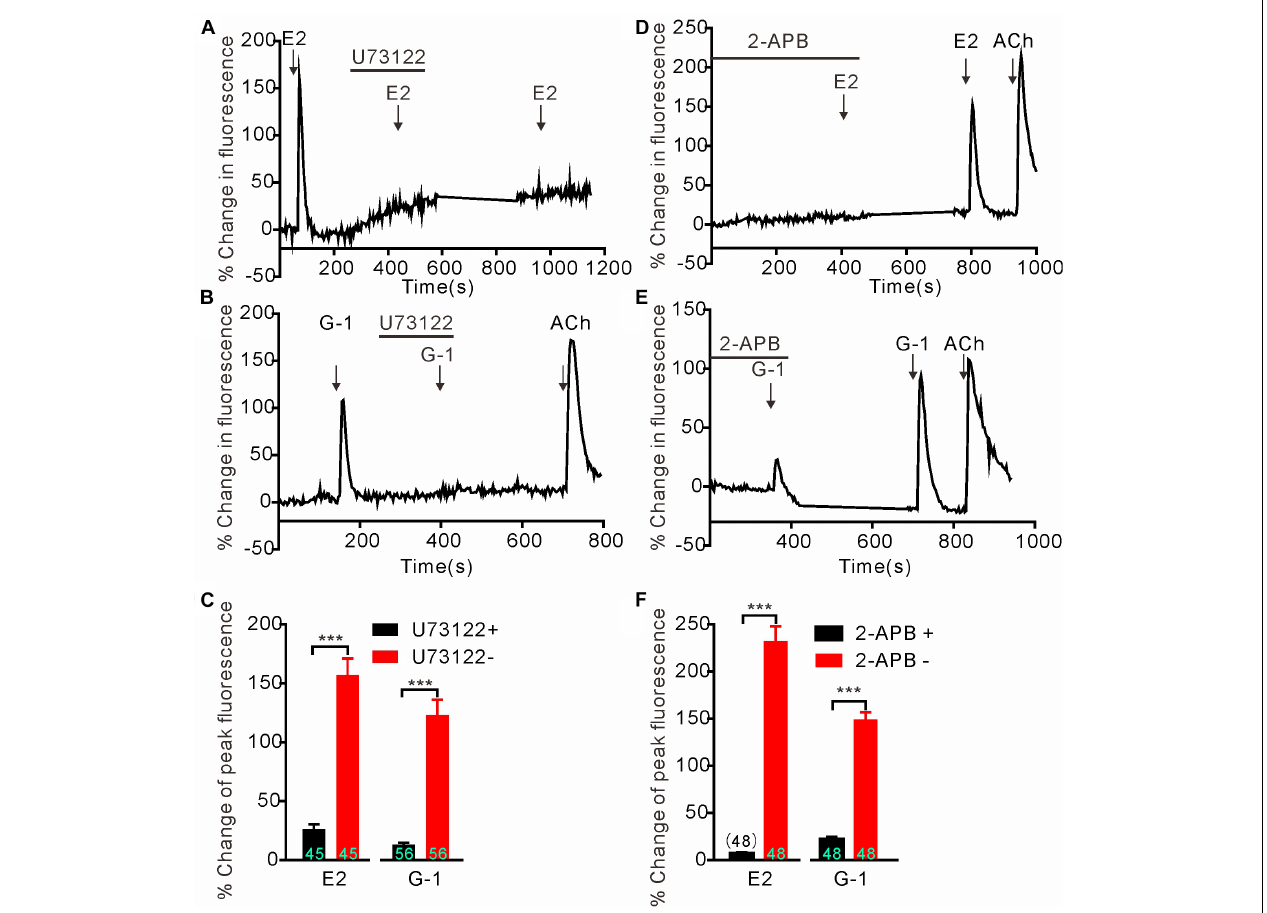
FIGURE 3 | G protein-coupled estrogen receptor-mediated rapid calcium rise in SH-SY5Y cells is via the PLC/IP3 pathway. (A–C) The PLC inhibitor U73122 (3 µ M) completely blocked the calcium response to E2 (1 µ M) and G-1 (1 µ M). (D–F) The store calcium release channel (IP3R) blocker, 2-APB, virtually abolished G-1 or E2-evoked calcium responses. The example traces (A,B,D,E) are the average percentage change in fluorescence of 16–25 cells in one visual field. (C,F) The averaged peak percentage changes in fluorescence in different conditions. ∗∗∗ P < 0.001, paired t -test. n = 45 ∼ 56 cells from three to four independent